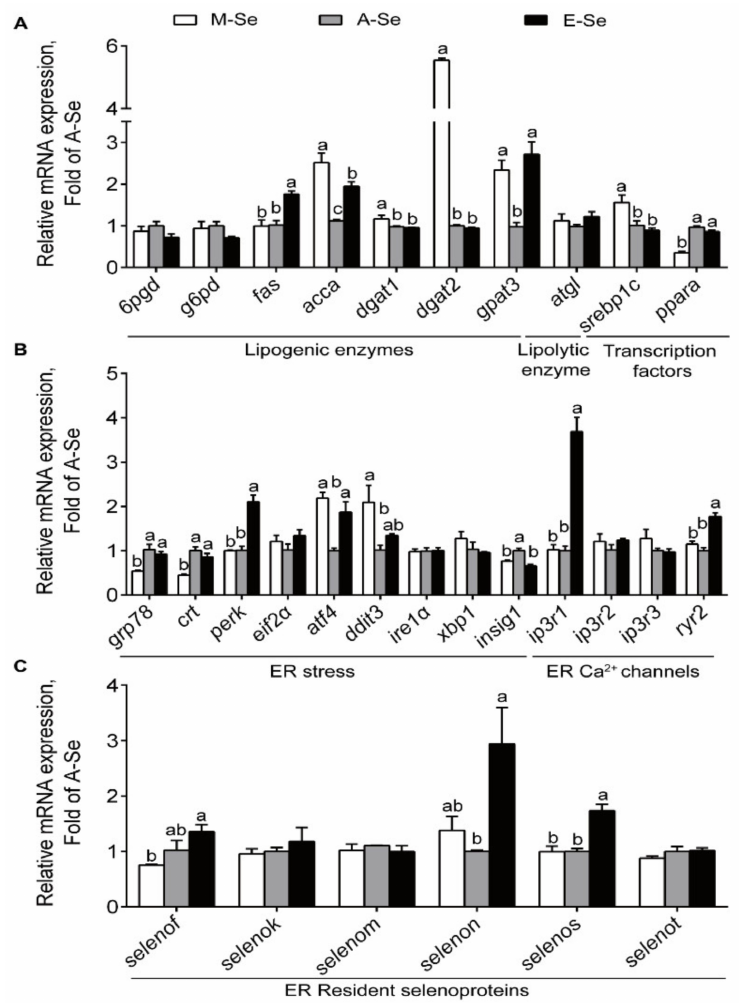
Figure 6. Relative mRNA levels of lipid metabolism ( A ), ER stress and ER Ca 2+ channels ( B ), related genes and selenoproteins ( C ) in the MI of yellow catfish fed diets varying in Se level for 12 wk. Values are means ± SEMs, n = 3 (replicates of 3 fish). Labeled means without a common letter differ, p < 0.05 (one-factor ANOVA, Duncan post hoc